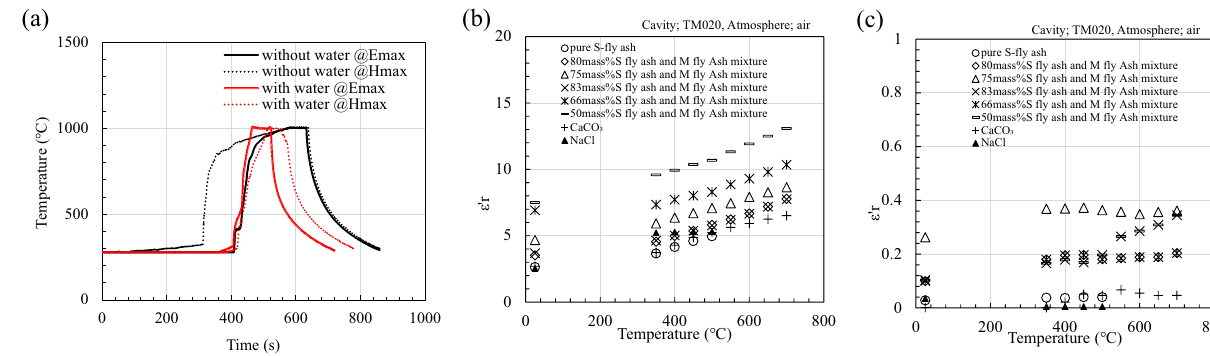
Figure 2. ( a ) Temperature change when the 1.5 g sample with (or without water) is heated by a microwave electric field (or magnetic) field (holding time: 1 min, holding temperature: 1000 °C, 0.4 L/min CO 2 ). Temperature dependence of the ( b ) real and ( c ) imaginary dielectric constants of the fly ash raw material measured by the resonant perturbation method (TM020,